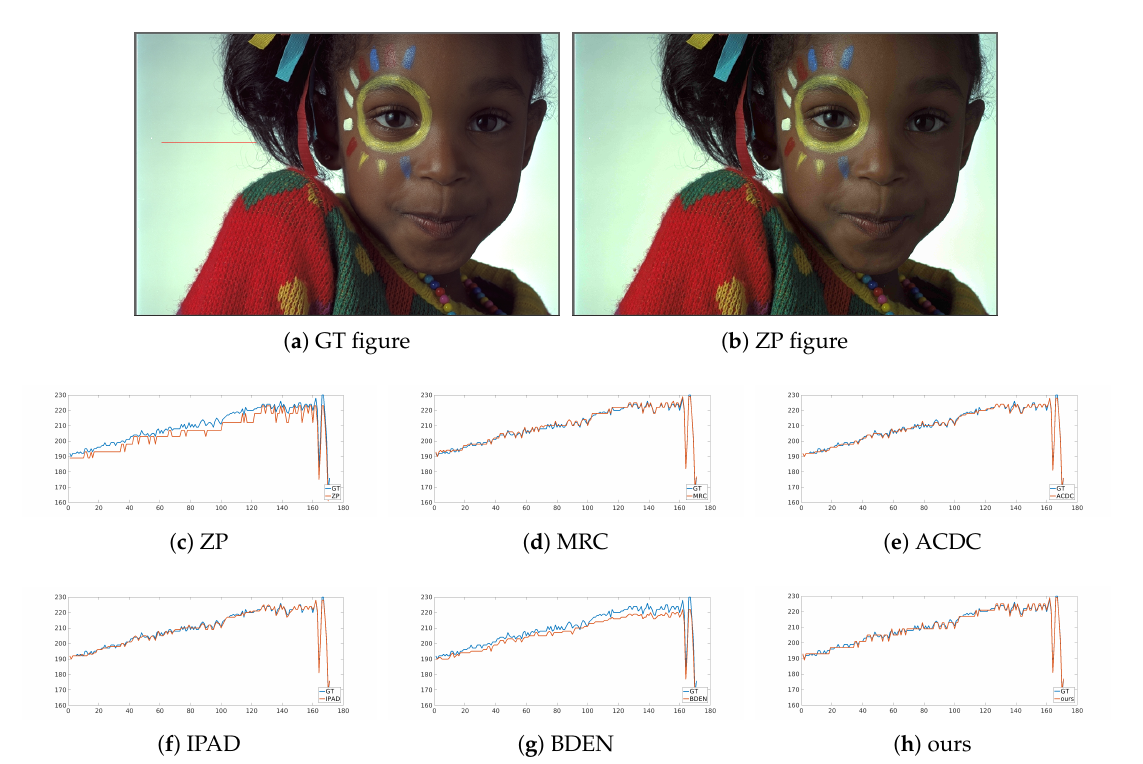
Figure 7. Intensity curves of 6bit-8bit natural BDE image from